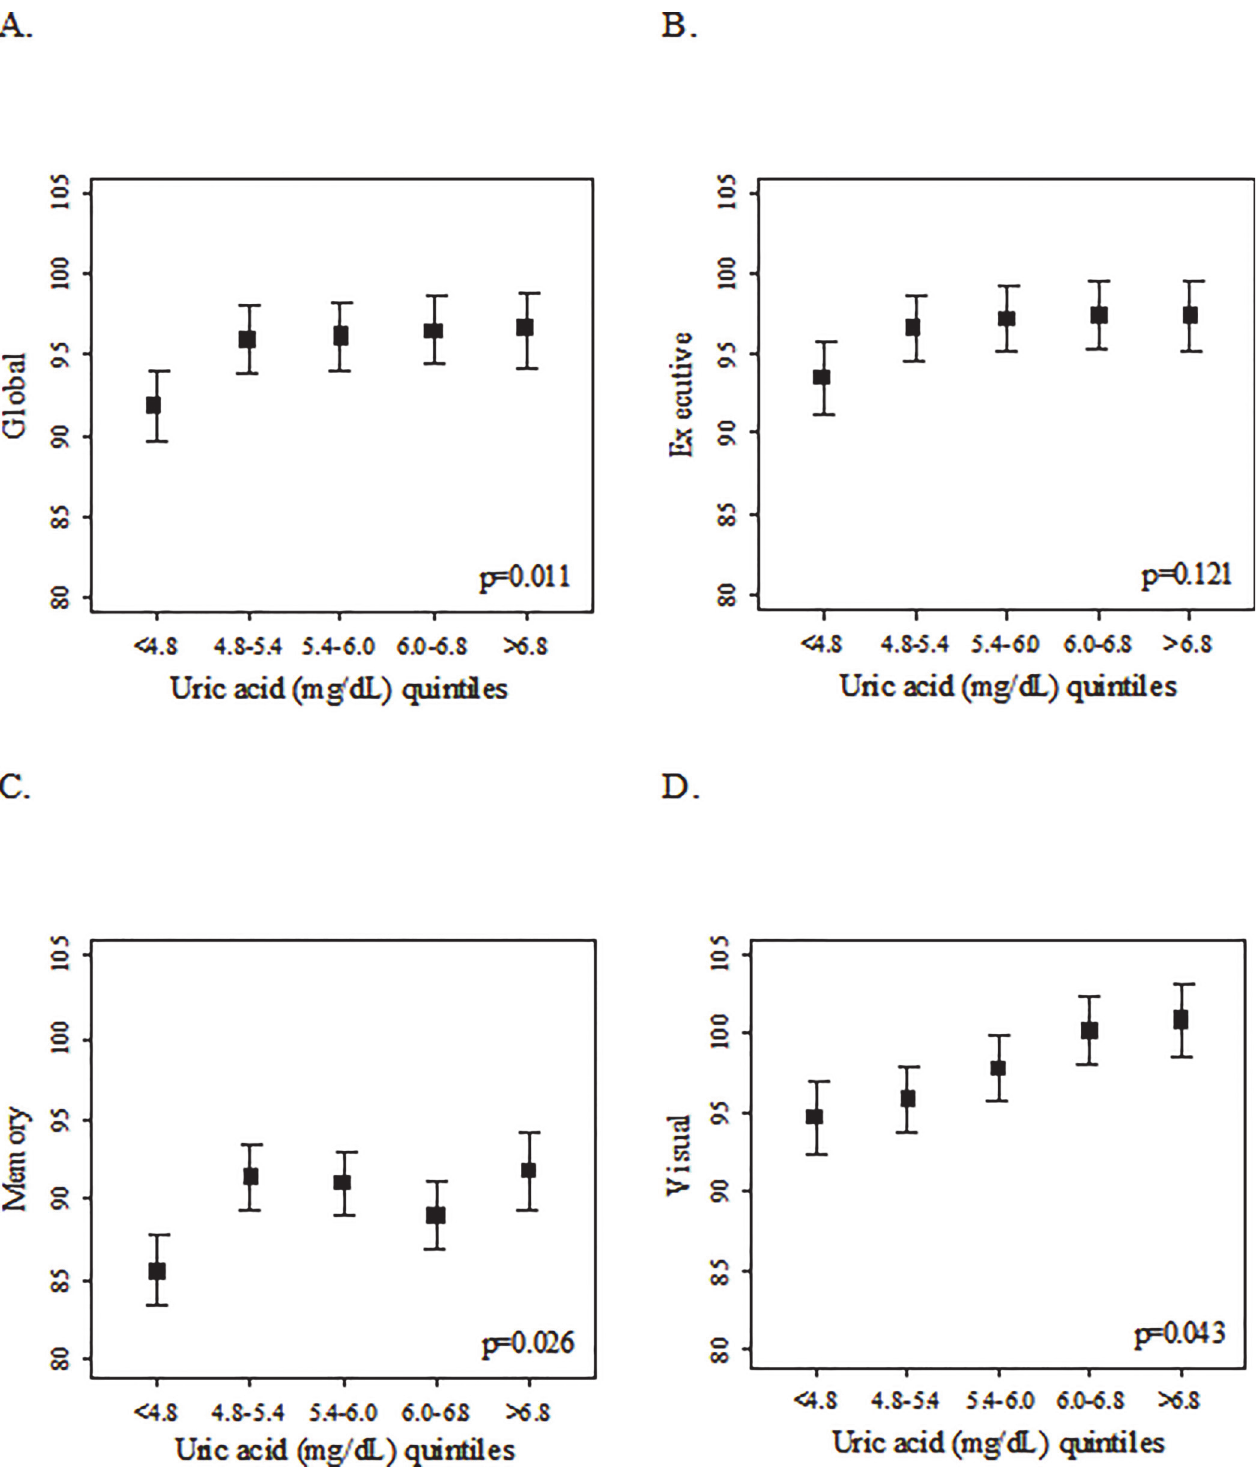
Fig 2. Unadjusted means and 95% CI of cognitive global (panel A), executive function (panel B), memory (panel C) and visual (panel D) scores by uric acid quintiles. Since transformation of power of 4 was required for the attention cognitive domain to approximate normality a figure of unadjusted means for the attention domain is not presented. P value for the attention cognitive domain is